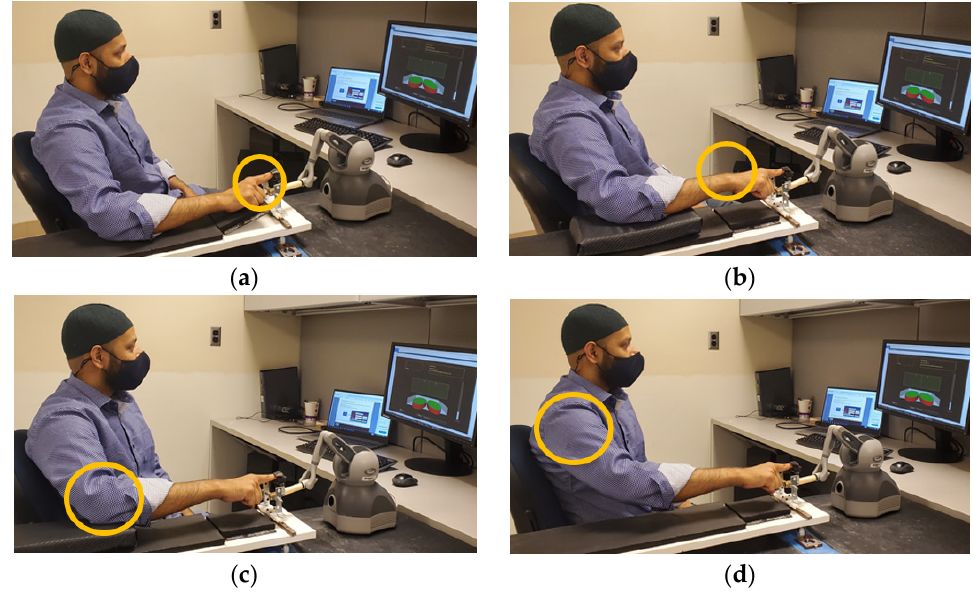
Figure 1. User interface for the stiffness discrimination task: ( a ) metacarpophalangeal joint as the pivot joint; ( b ) wrist joint as the pivot joint; ( c ) elbow joint as the pivot joint; ( d ) shoulder joint as the pivot joint.